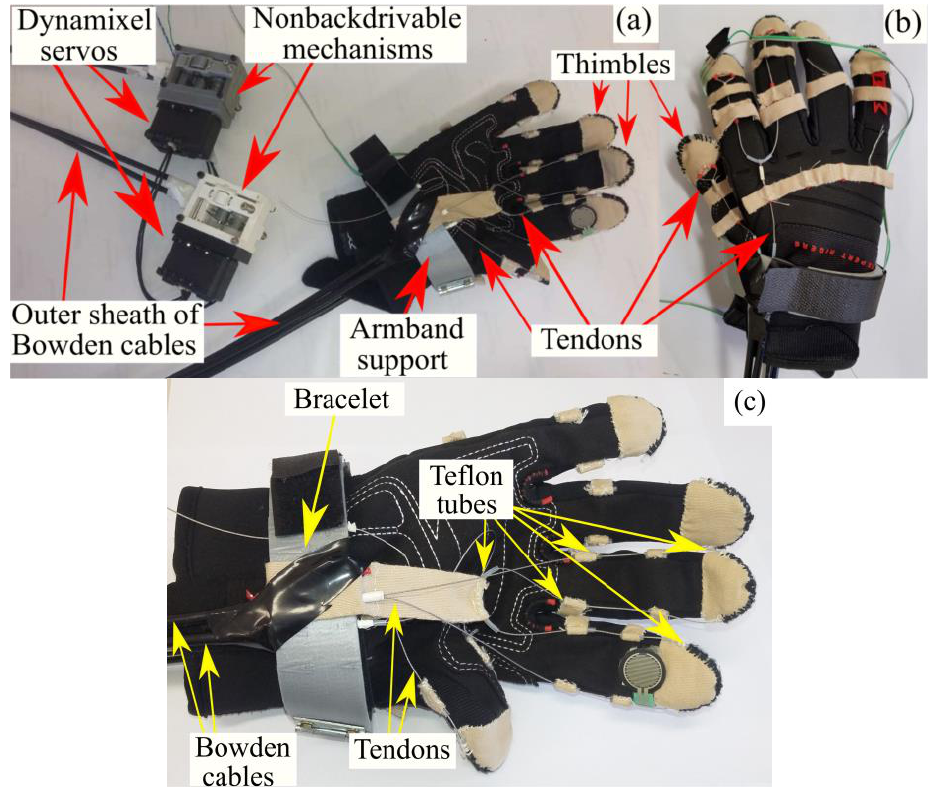
Figure 3. Robotic glove: ( a ) system parts; ( b ) dorsal and ( c ) palmar sides.